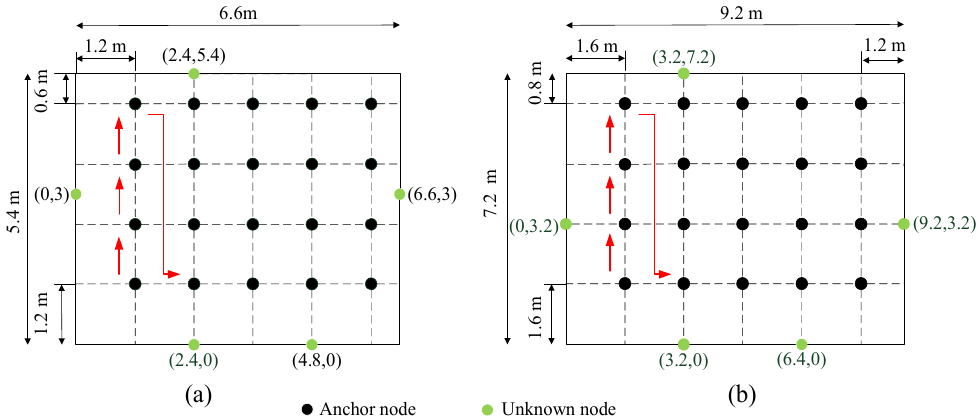
Figure 13. ( a ) Indoor localization field; ( b ) outdoor localization field and the hall. The black nodes represent the unknown node. The green nodes represent the anchor nodes. The red arrow represents the unknown node movement path. According to Formulas (1) and (2), the obtained RSSI data are transformed into dis- tance information to obtain the data shown in Table 4. The horizontal header represents the label of the five anchor nodes. The vertical header represents the position where the unknown node has moved to. The data in the table represents the average distance meas- ured by the anchor nodes when the unknown node moves to the specified position in a sequence in the three positioning environments. Table 4. The distances obtained from anchor nodes.